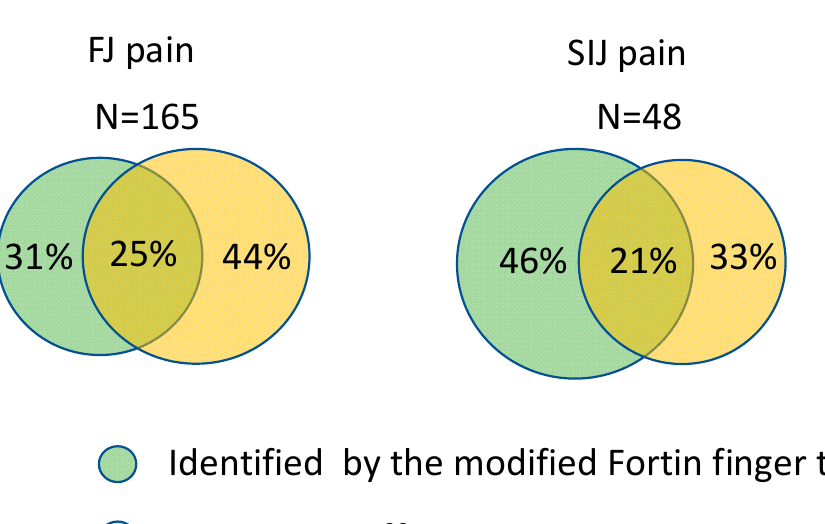
Figure 1. Overlap of sources identified by the modified Fortin finger test and 99m Tc-MDP SPECT for FJ and SIJ pain.